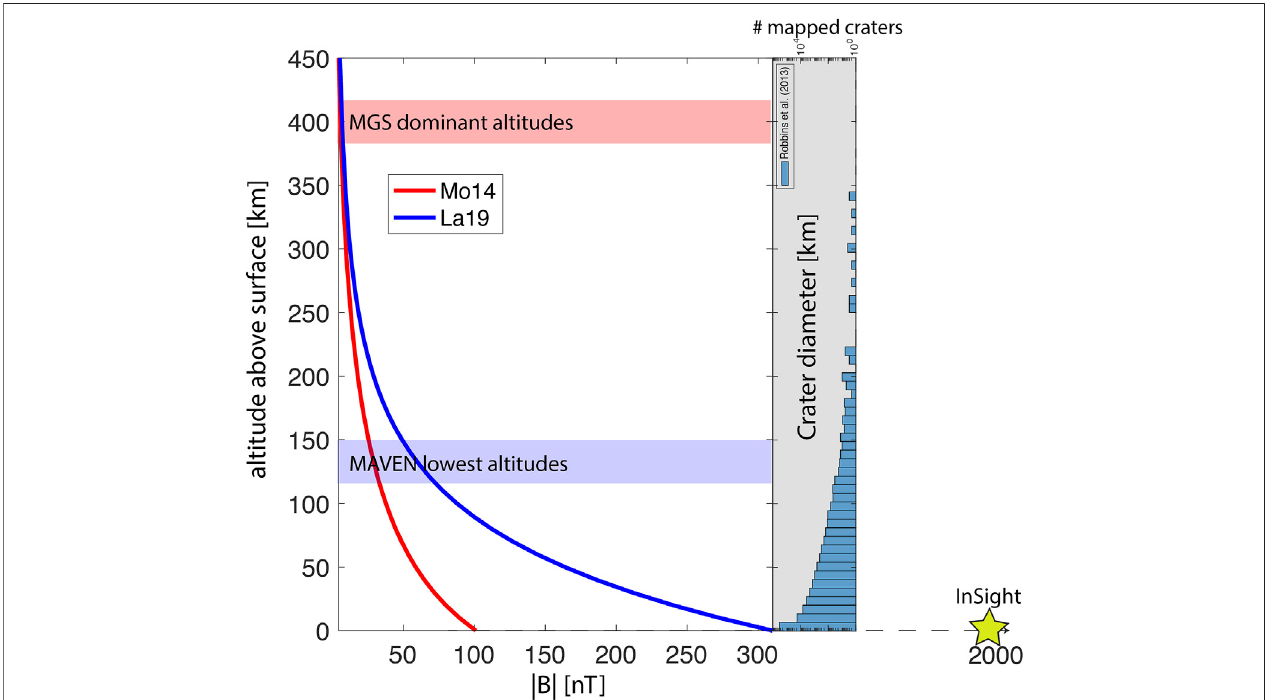
FIGURE 3 | Models of the crustal magnetic fi eld predicted at the InSight landing site. Mo14 (red) includes only MGS data (Morschhauser et al., 2014), La19 also includesMAVENdata(Langlaisetal.,2019).Theshaded red/blue zoneshighlightthealtitudesofdataacquisitiontoindicateapproximatespatialresolutionofrespective models. The surface measurement is shown by the yellow star. A crater size distribution from Robbins et al. (2013) shows an example of the increase in the number of smaller surface features for which magnetic analyses are only possible with improvements in data resolution.